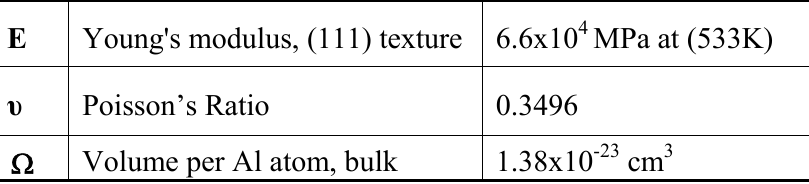
Table 1. Al material properties used in